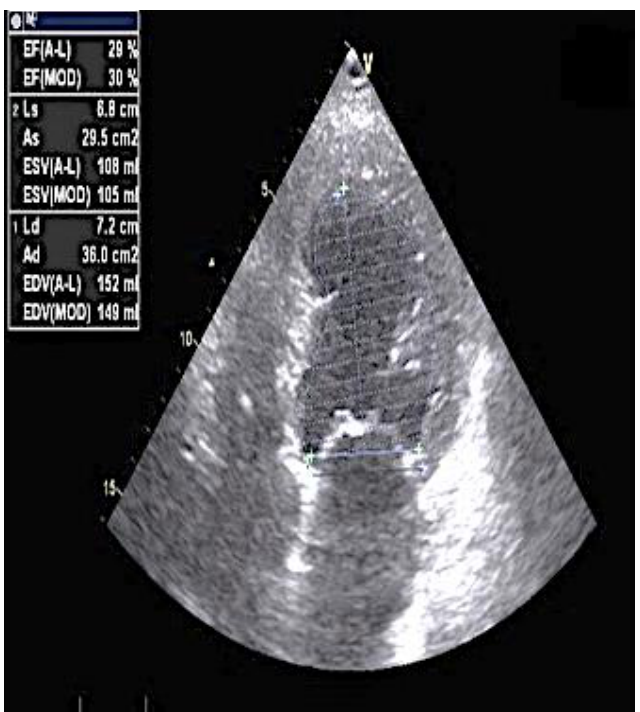
Figure 1. The four chambers viewed at admission. Note the severe reduction in systolic function (LVEF 30% using the Simpson biplane method).